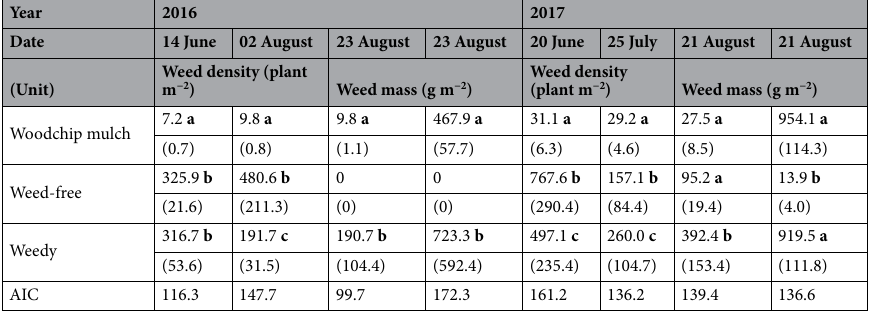
Table 1. Mean (1 SD) values of weed density and the aboveground dry mass of weeds among three replicates in each treatment. To examine the weed dry mass, all weeds were harvested on 23 August 2016 and on 21 August 2017 in all treatments. In the weed-free treatment, all weeds were harvested three times a year by hand. Different letters (a, b, c) on each day show significant differences ( P < 0.05) among the treatments by generalized linear mixed models (GLMMs) including random effects among three